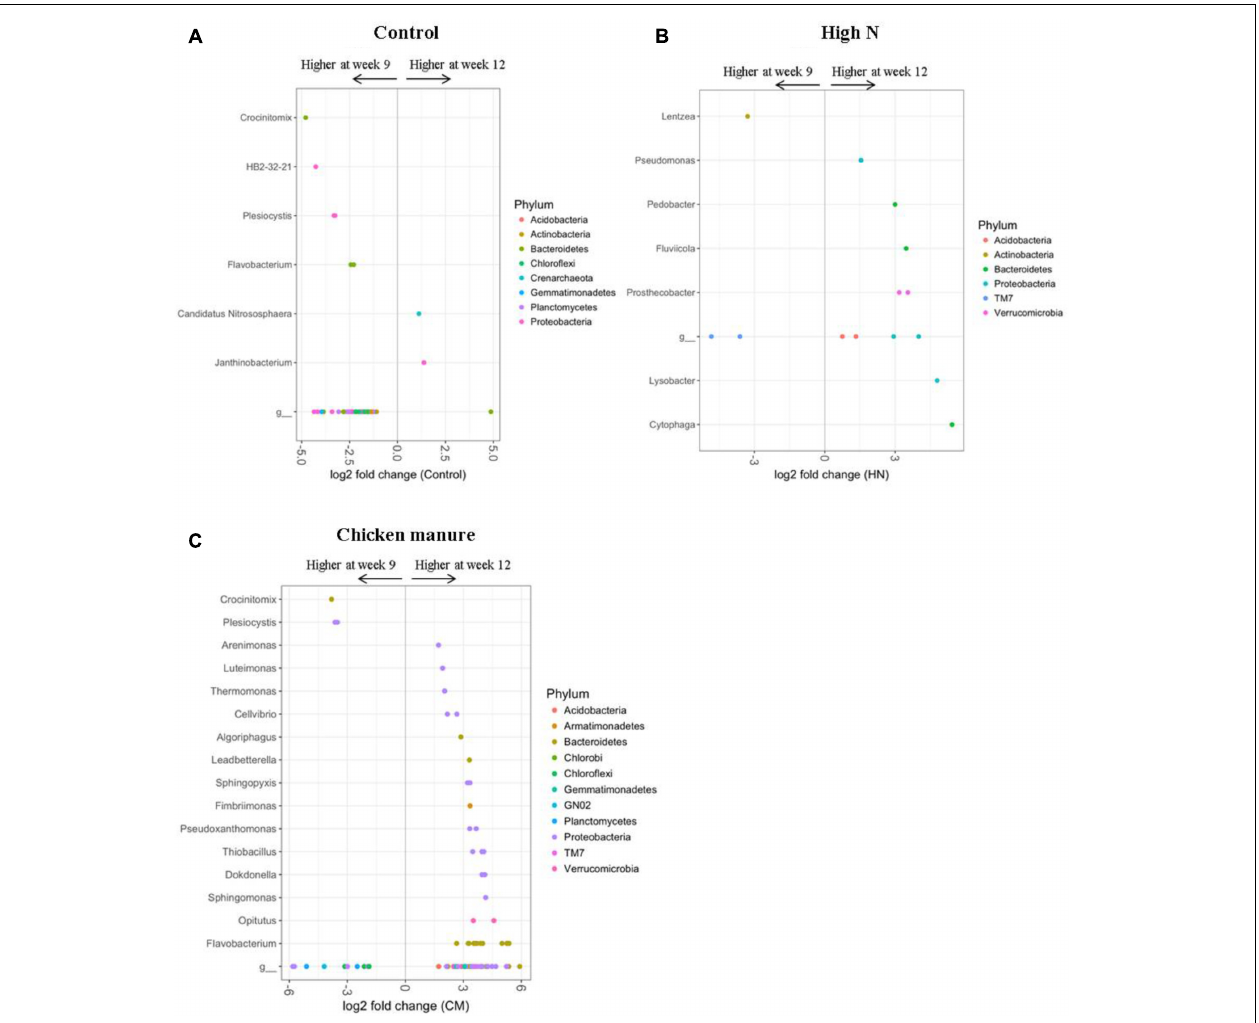
FIGURE 6 | DESeq2 analysis results indicating the fold-change of bacterial genera in rhizosphere communities of 12-week-old plants relative to 9-week-old plants within the (A) control, (B) HN, and (C) CM treatments (LN treatment only had one significantly different classified OUT at the genus level) ( p < 0.001). “g” Represents OTUs that were not classified at the genus